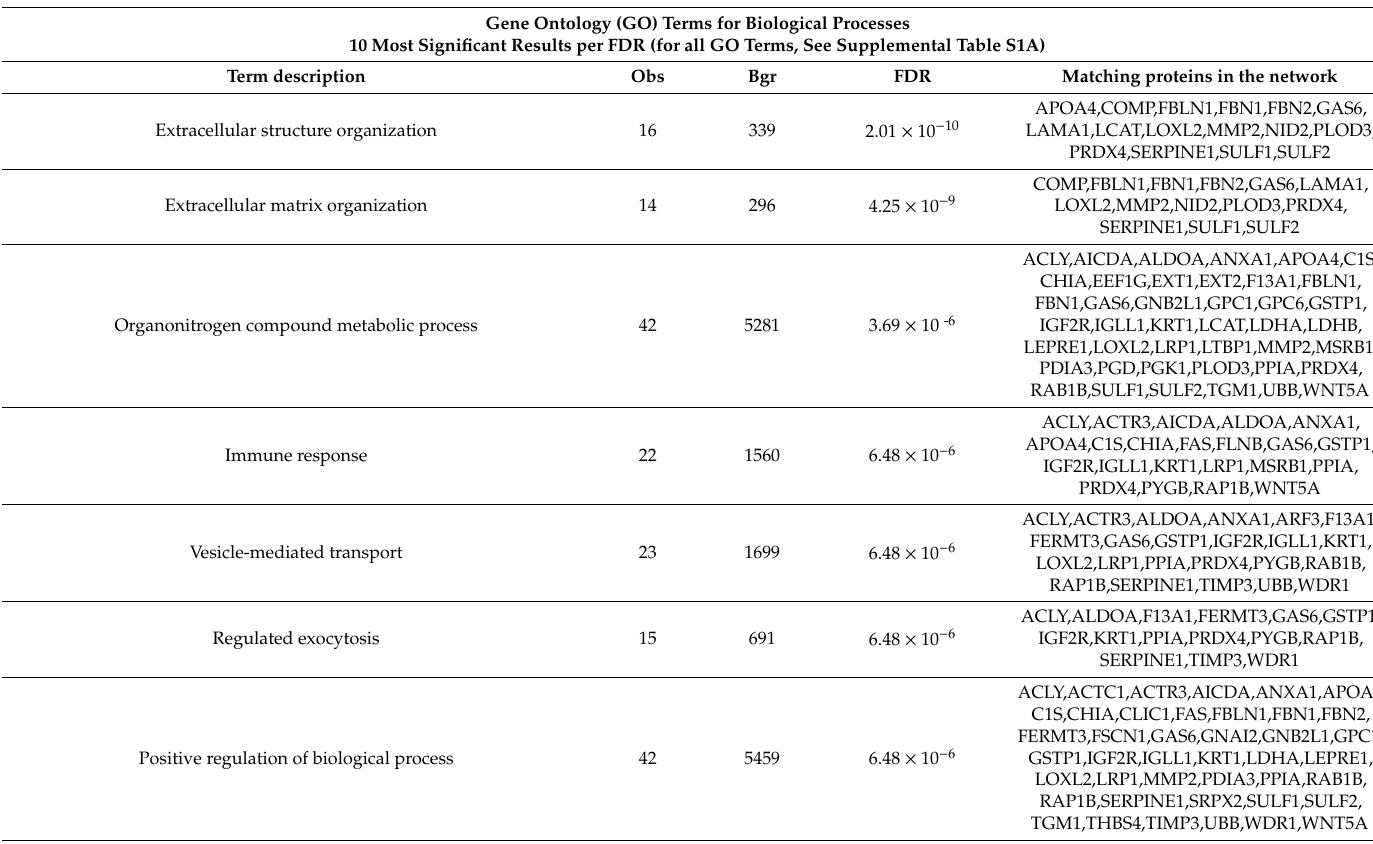
Table 4. Biological processes, KEGG pathways, and PMIDs for the EV surface unique proteins in the control group for the control vs. HIV comparison. Gene Ontology (GO) Terms for Biological Processes 10 Most Significant Results per FDR (for all GO Terms, See Supplemental Table